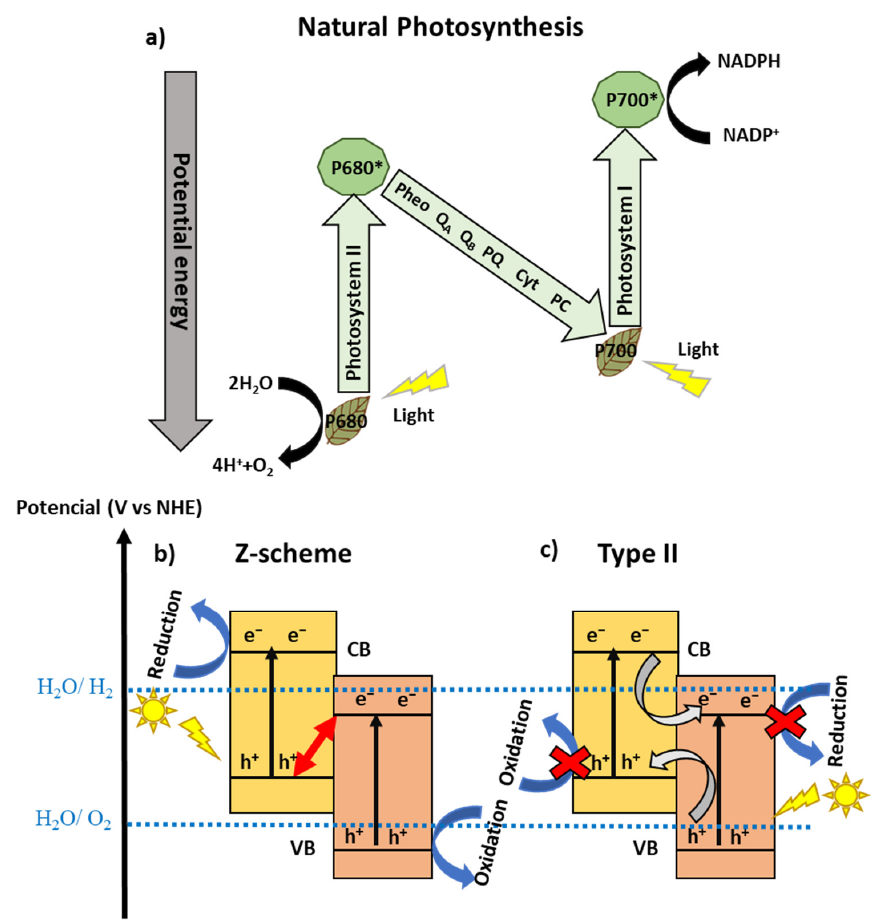
Figure 4. ( a ) Scheme of the charge separation and transformation process mechanism of natural photosynthesis. Adapted from [33]. Copyright 2019, Elsevier. ( b ) Z-scheme schematic diagram and ( c ) type II schematic diagram. Adapted from [28].